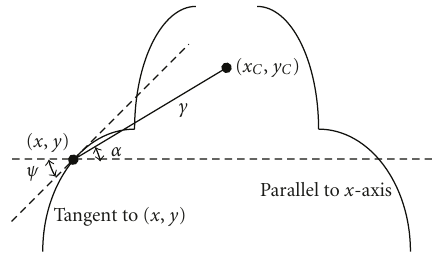
Figure 5: Head-shoulder contour under HT. In template genera- tion, the relative position of ( x C , y C ) to ( x , y ) is recorded in ( r , α ); in contour matching, the pixel value on the assumed position of ( x C , y C ) is incremented by 1 on the detection